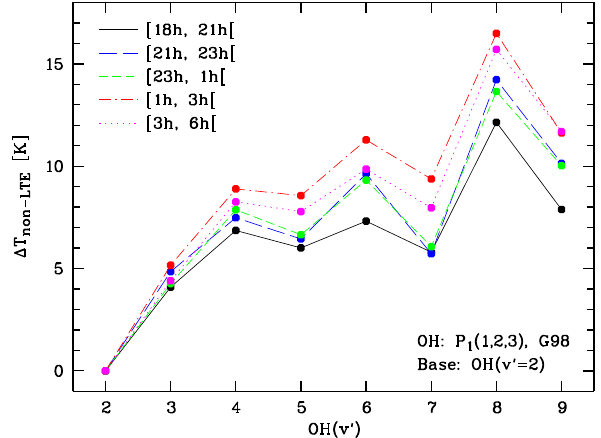
Figure 15. v (cid:48) -dependent non-LTE contributions to OH T rot based on the first three P 1 lines and HITRAN data (Goldman et al., 1998) for five nighttime LT periods derived from the full X-shooter sam- ple. The LTE base temperature for each v (cid:48) was derived from the corresponding O 2 a (0-0) T rot corrected for the difference in the VER profiles. The uncertainties of the absolute (cid:49)T non-LTE are similar to those given in Fig. 13 (excluding the unknown uncertainties of the molecular parameters). Comparisons of (cid:49)T non-LTE for the different night-time periods and/or v (cid:48) are more reliable. The errors should be of the order of 1K, i.e. very likely smaller than 2K.